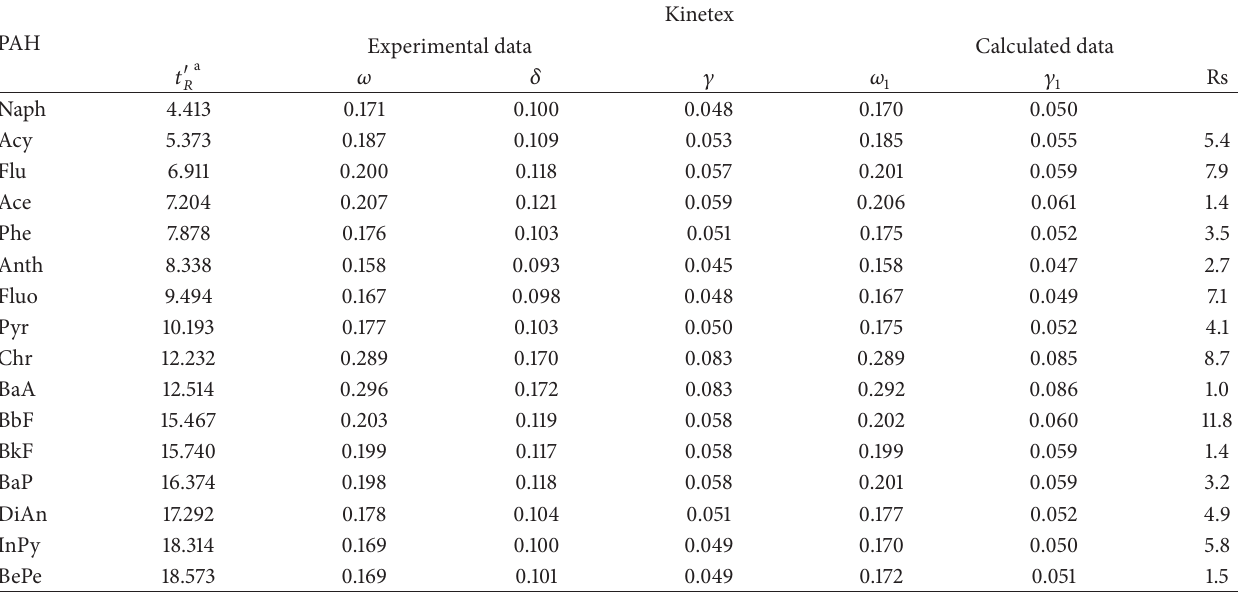
Table 3: Peak characteristics of the 16 PAHs obtained with the Kinetex columns at 16 ∘ C. PAH